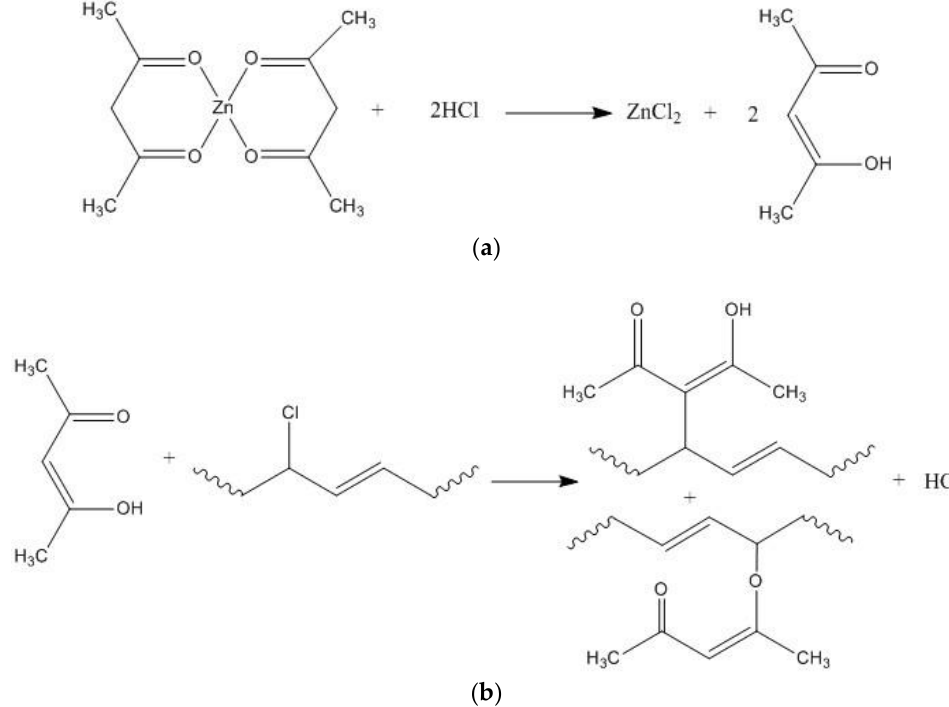
Figure 11. Mechanism of action of zinc acetylacetonate as auxiliary heat stabilizer. ( a ) absorb acid; ( b ) PVC polymer chains crosslinking.